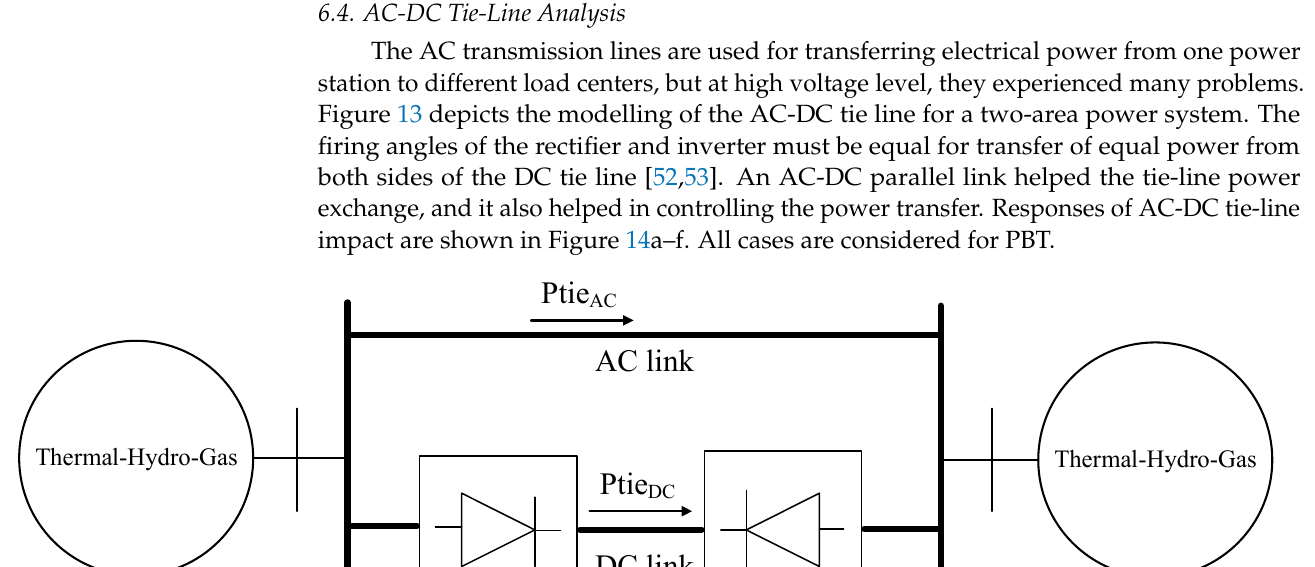
Figure 13. AC-DC parallel links for the considered system.